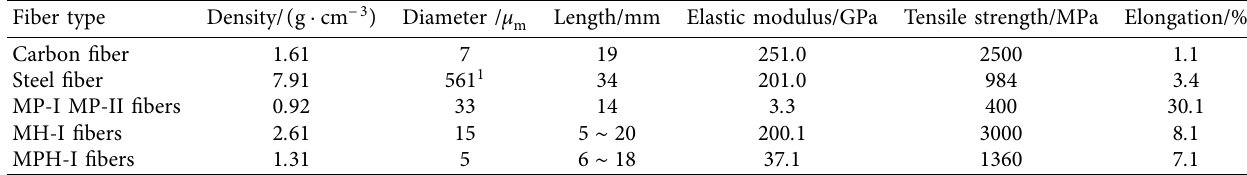
Table 1: Physical and mechanical properties of fbers.